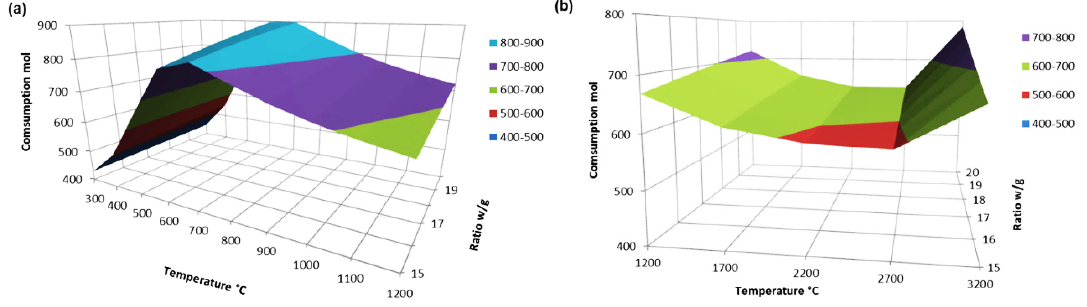
Figure 6. Water consumption at 0.1 MPa from ( a ) 300 to 1200 °C and ( b ) 1200 to 3200 °C.